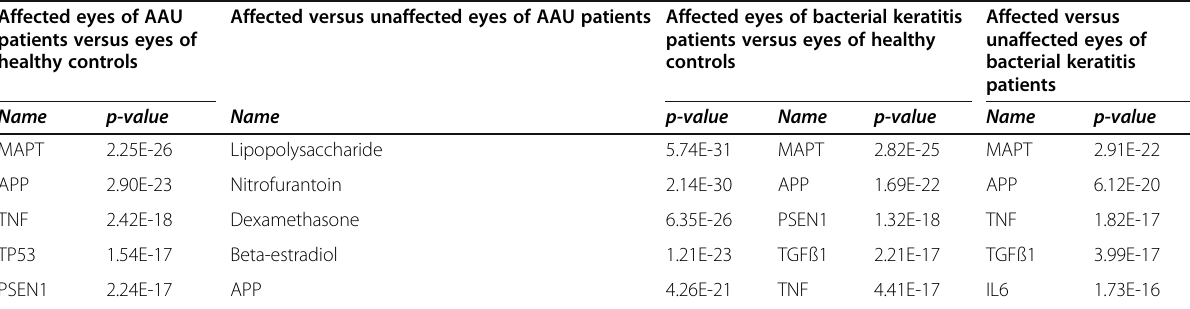
Table 4 Top upstream regulators Affected eyes of AAU patients versus eyes of healthy controls